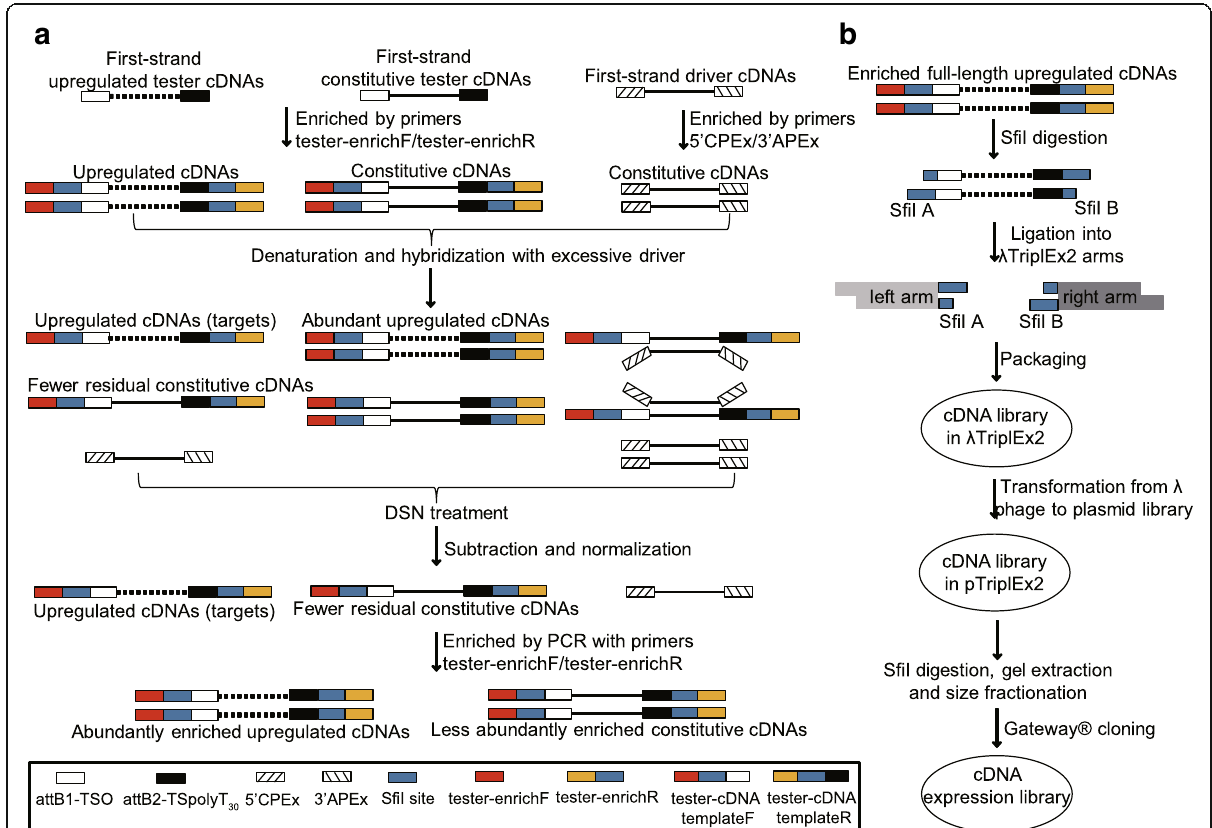
Fig. 1 Schematic drawings of DSH and construction of the cDNA library of upregulated transcripts. a Different primers were used for the synthesis of first-strand tester and driver cDNAs. White and black boxes represent the 5 ′ and 3 ′ ends of the tester-cDNAs and the att B1 and att B2 sites in primers attB1-TSO and attB2-TSpolyT 30 , respectively. Striped boxes represent the 5 ′ and 3 ′ ends of driver-cDNAs and corresponding primers 5 ’ CPEx and 3 ’ APEx, respectively. Red boxes represent the 5 ′ ends of the tester and corresponding primer tester-enrichF. Blue boxes represent the Sfi I sites and, together with yellow boxes, represent the 3 ′ ends of tester and corresponding primer tester-enrichR. Solid lines represent constitutive cDNAs. Dashed lines represent upregulated cDNAs. Primers tester-enrichF/tester-enrichR were used to enrich tester. 5 ’ CPEx/ 3 ’ APEx were used for driver enrichment. The excessive driver was hybridized with tester and renatured double-strand cDNAs were removed by the DSN. The resulting single-strand molecules, mostly upregulated cDNAs, can be amplified by tester-enrichF/tester-enrichR. b Flow chart of construction of the library of upregulated cDNAs. The Sfi I-digested cDNA molecules were ligated with left and right arms of the phage vector λ TriplEx2. The ligation product was packaged and used for transformation of E.coli strain BM25.8 to obtain the plasmid cDNA library in pTriplEx2. The resulting products of Sfi I-digested pTriplEx2 library were size fractionated with agarose gel electrophoresis, and different sized fragments were used for the construction of cDNA expression libraries via the Gateway® cloning